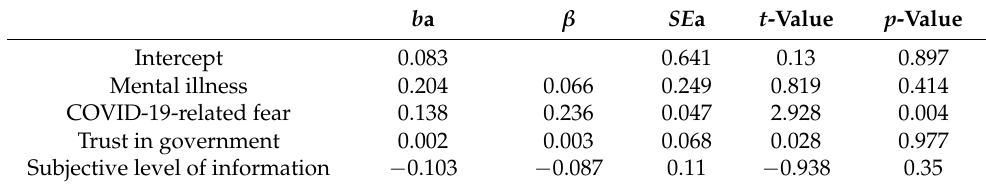
Table 3. Regression coefficients predicting an increase in depression symptoms (PHQ-2).